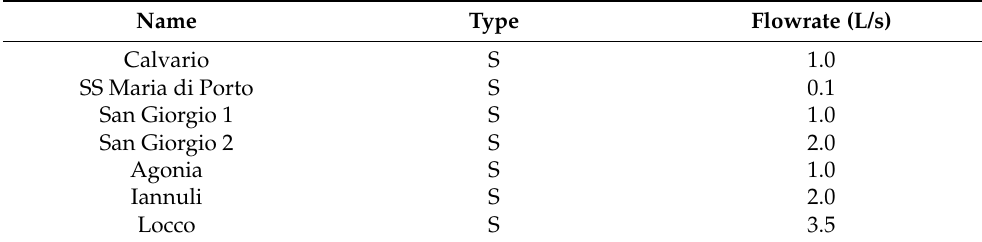
Figure 8. Boundary conditions together with relevant elements included in the model. Table 3. Springs/Sources (S) detected in the study area. The reported values were observed in February